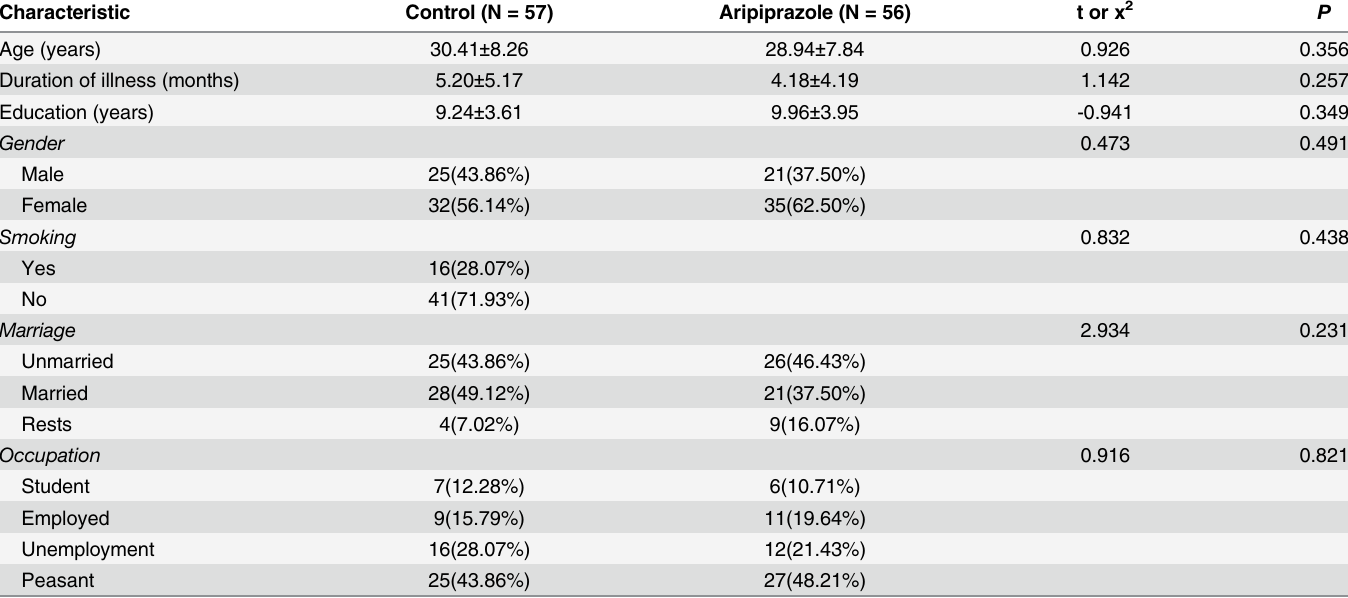
Table 1. Demographic and clinical characteristics of study participants. Values are mean ± SD.